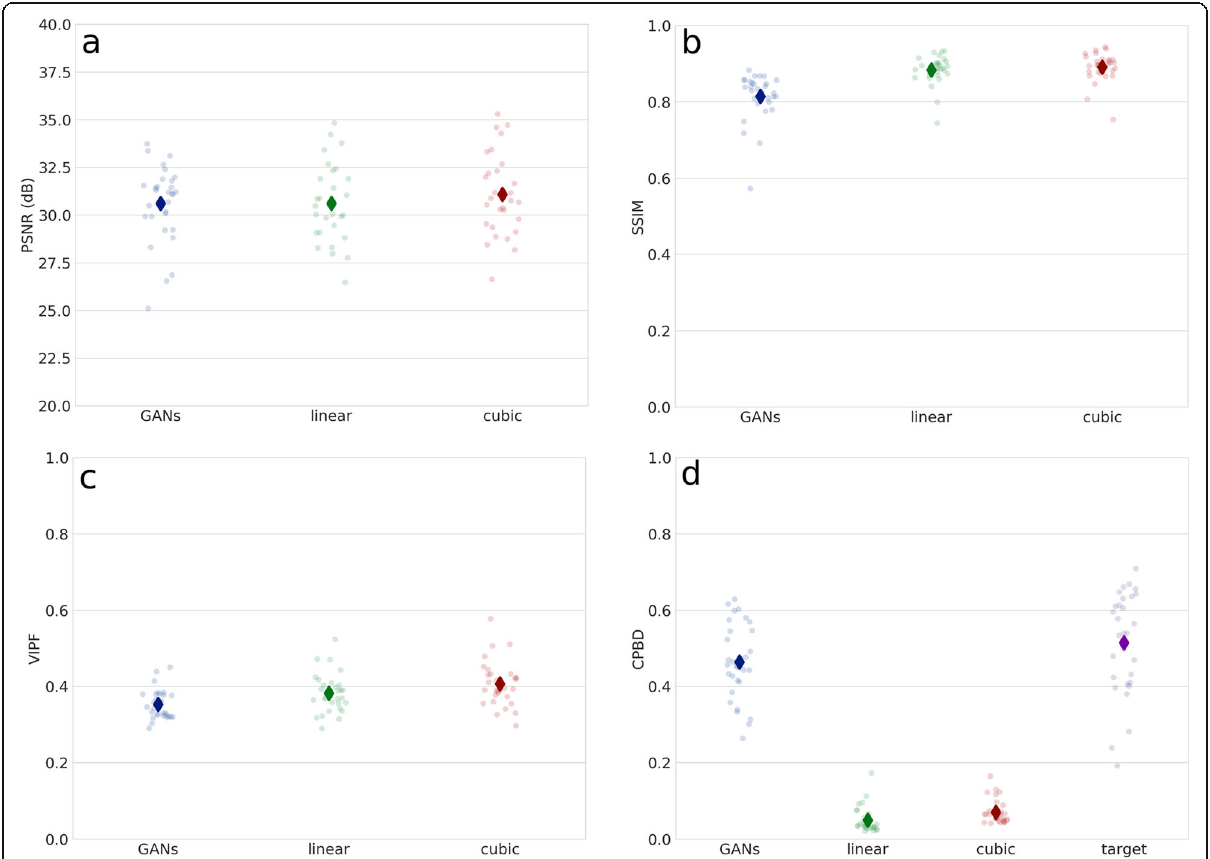
Fig. 3 Quantitative comparison among the outputs of GANs (GANs), linear resampling (linear) and cubic resampling (cubic) by means of the metrics PSNR ( a ), SSIM ( b ), VIPF ( c ) and CPBD ( d ). For CPBD, the value of the metric calculated for the target image (target) is also shown for the sake of